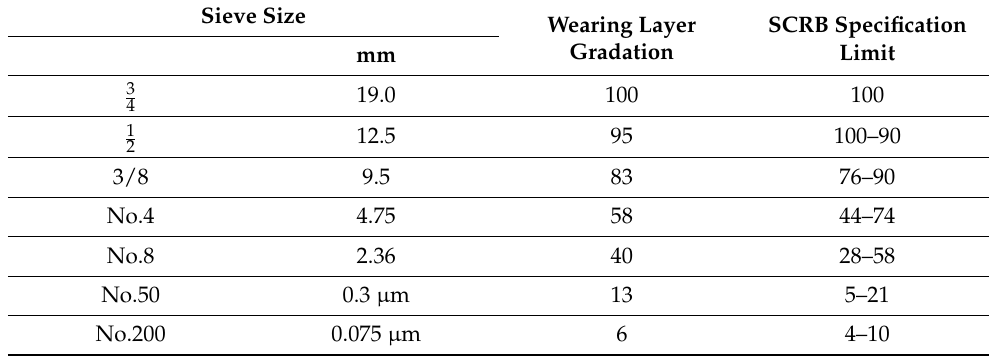
Table 5. Selected gradation of